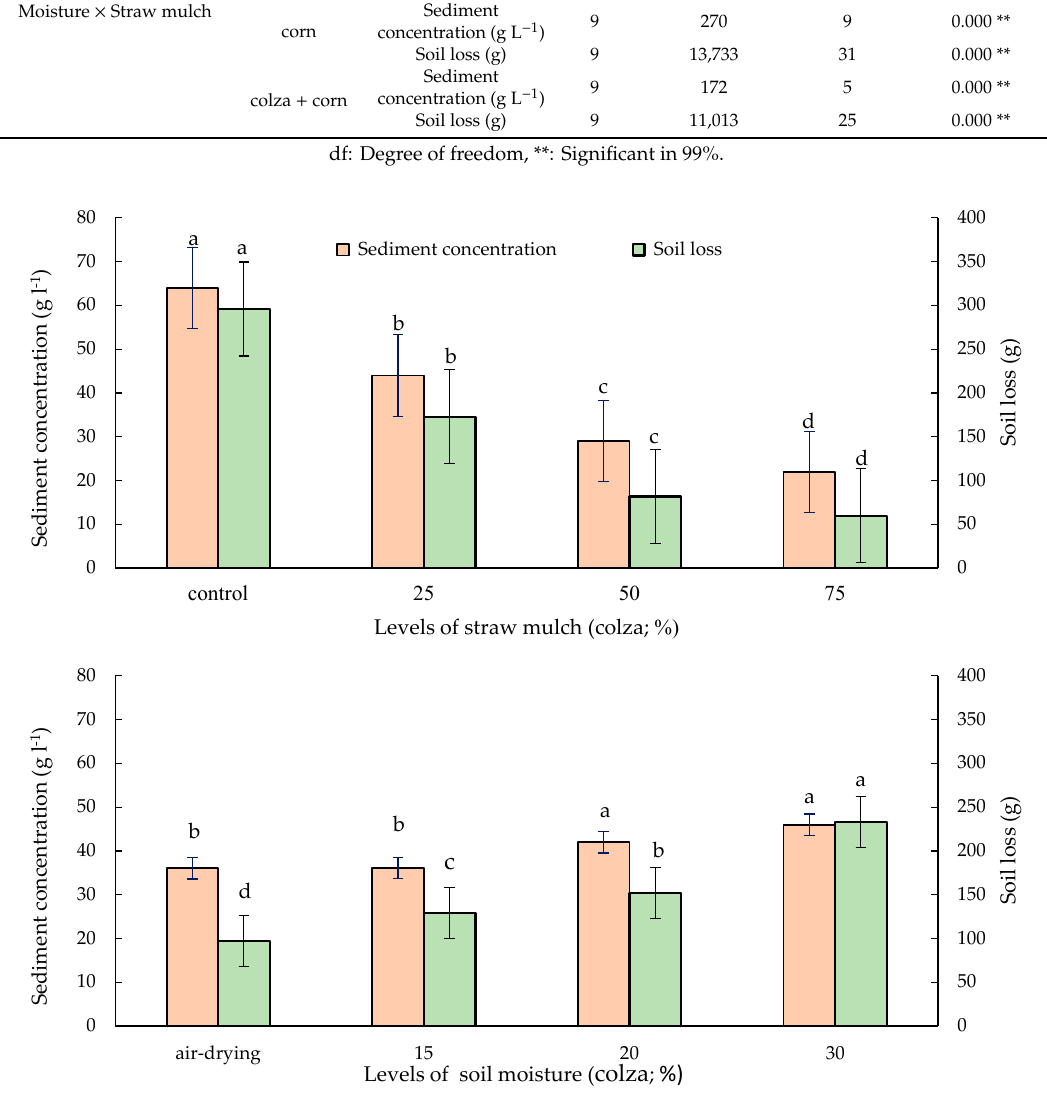
Figure 5. Comparison of soil loss and sediment concentration at di ff erent levels of colza straw mulch (above) and soil moisture conditions (below), based on the Duncan